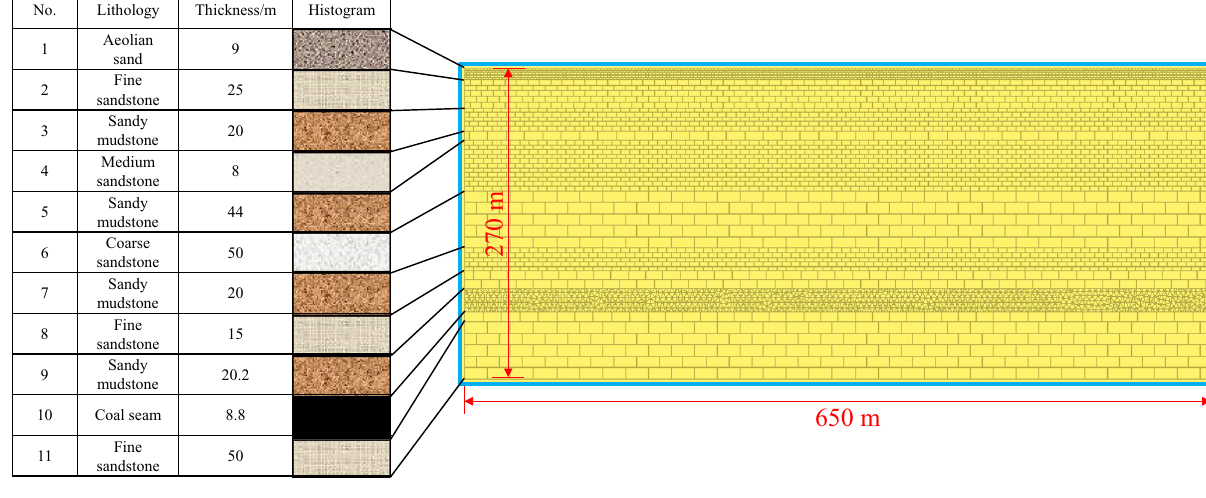
Figure 3. Numerical model.